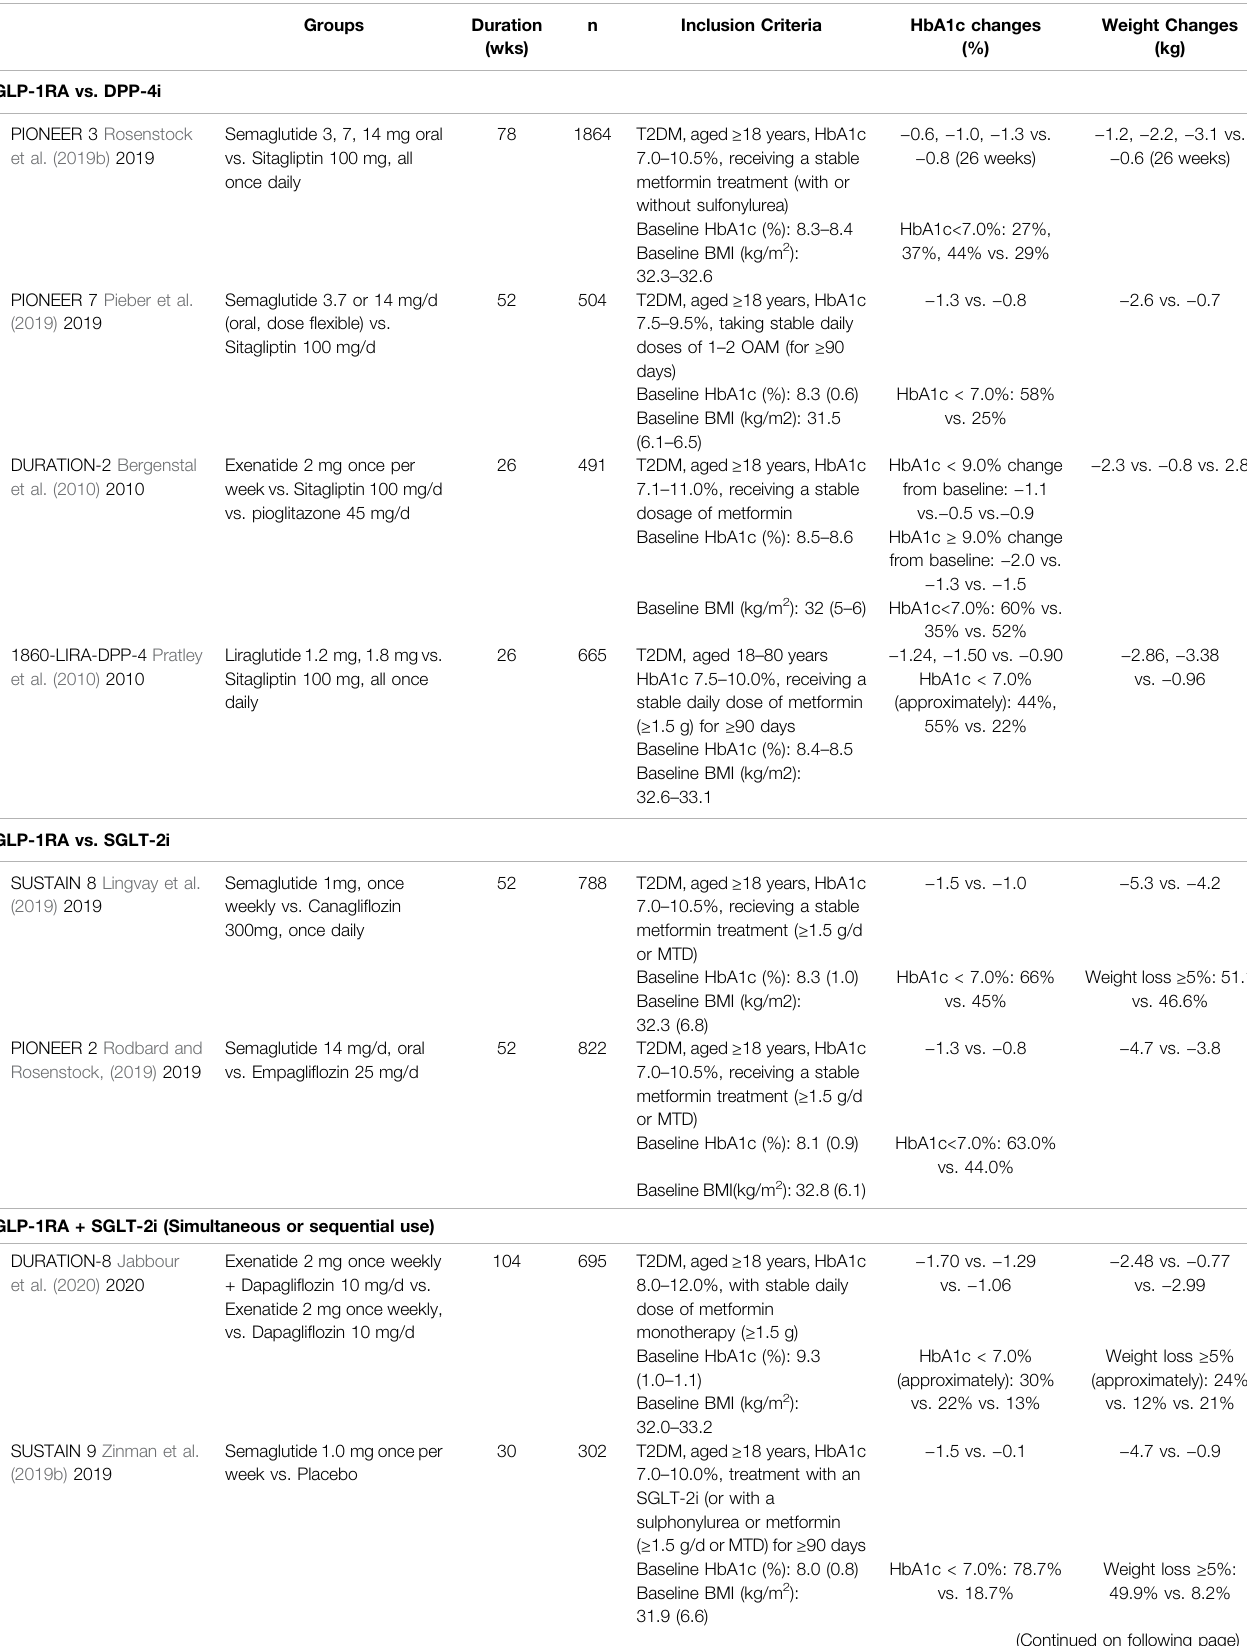
TABLE 1 | Randomized controlled trials of GLP-1RA, SGLT-2i and/or DDP-4i in T2DM (mainly phase